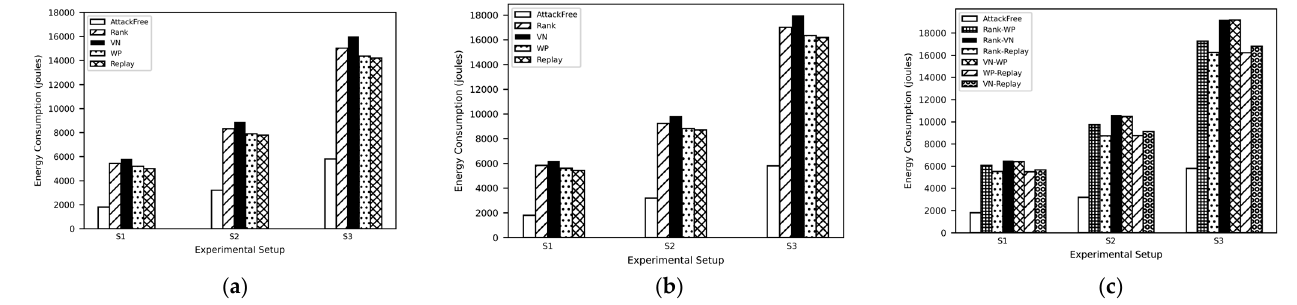
Figure 8. Energy Consumption Results: ( a ) Single-Attack Scenario; ( b ) Composite-Attack Scenario; ( c ) Hybrid-Attack Scenario.